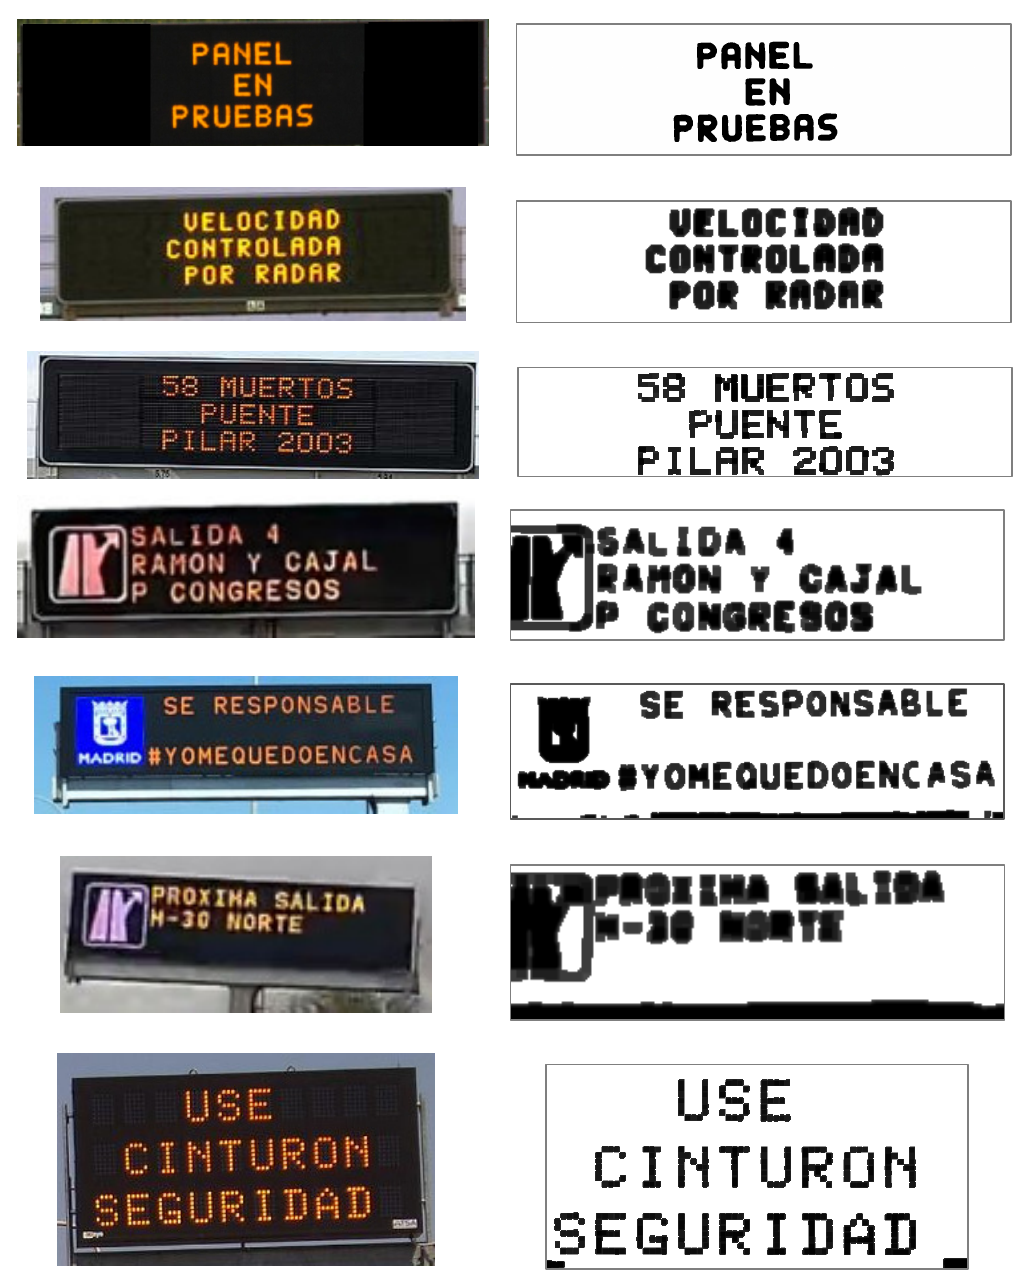
Figure 6. Image preprocessing examples.